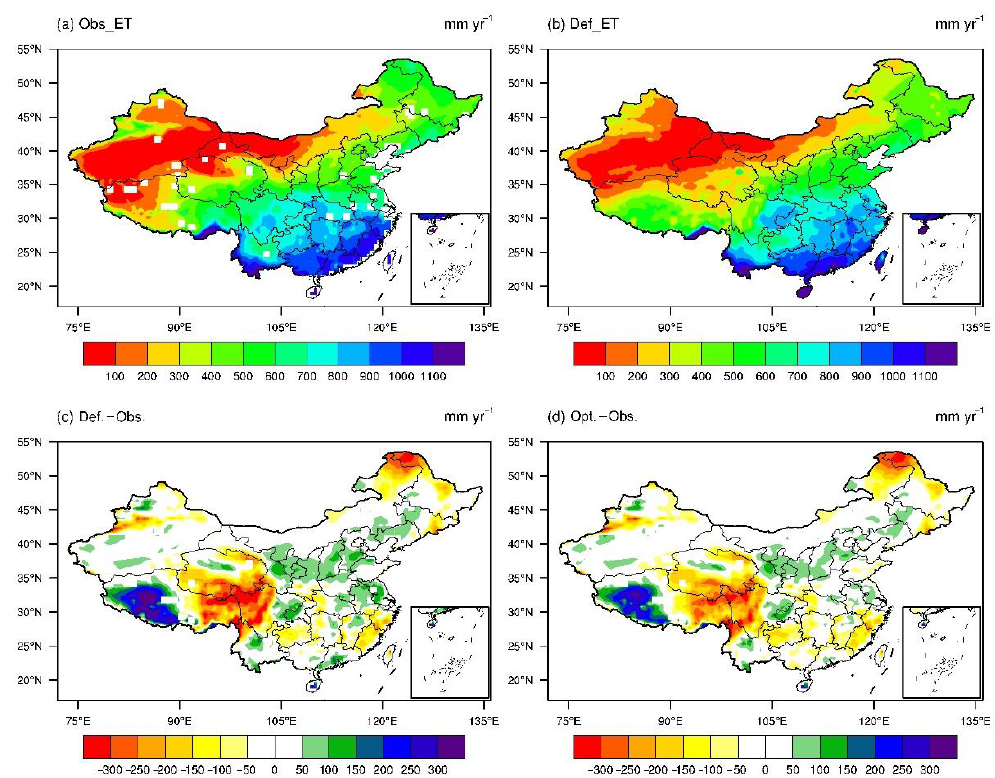
Figure 5. Comparisons of the spatial distribution of evapotranspiration simulations from 2009 to 2011 over China using Community Land Model version 4.0 model with default and optimal parameters: ( a ) observations. The white grids in China represent the missing values, ( b ) default simulations, ( c ) bias of default simulations minus observations, and ( d ) bias of optimal simulations minus observations.